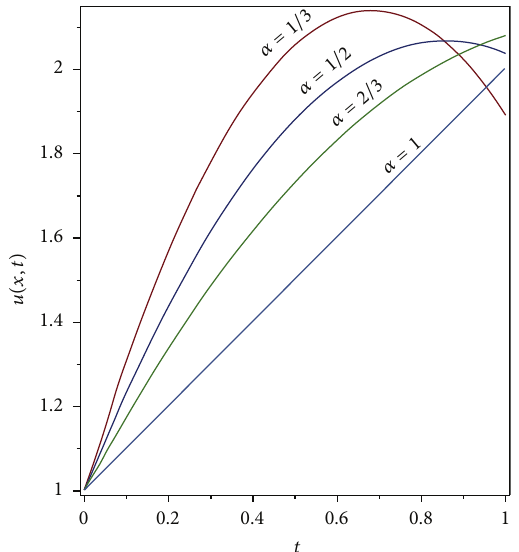
Figure 2: Plot of 𝑢(𝑥, 𝑡) for various values of 𝑡 and different values of 𝛼 , 𝑥 = 1